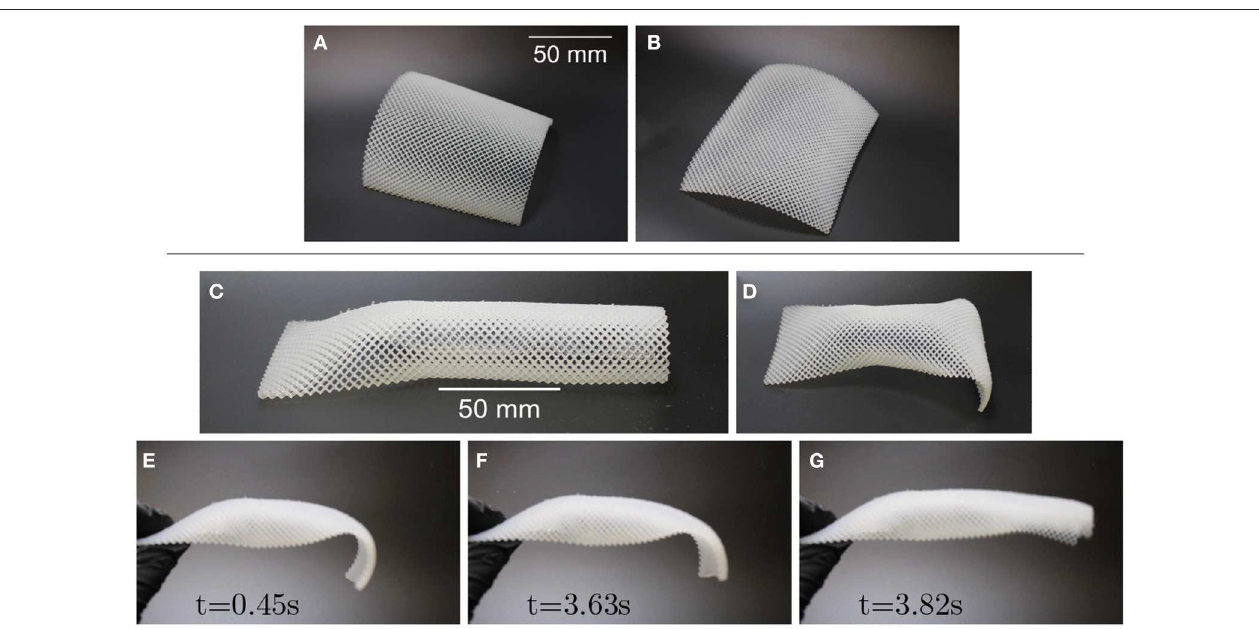
FIGURE 11 | A bistable conical gridshell; initial (A) and second (B) stable geometries. In (C) , a variable curvature gridshell is shown, which was printed flat one end and transitions to a cylinder over 1/3 of its length, with the remaining 2/3 maintaining a uniform cross-section. After actuation, the structure appears to have a second stable geometry, (D) , which subsequently snaps dynamically after some delay, i.e., it demonstrates pseudobistability. This is shown in timestamped frames from a recording (E–G) of the transition.